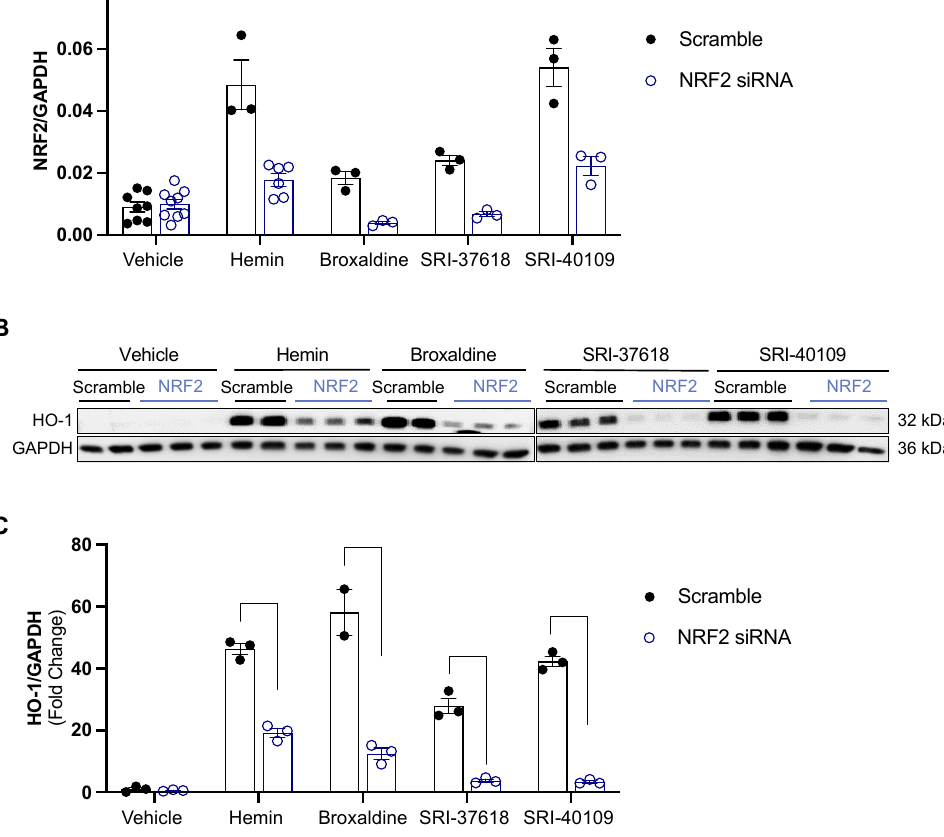
Figure 6. ( A ) Confirmation of NRF2 knockdown by real-time PCR. NRF2 gene expression is nor- malized to housekeeping gene GAPDH. ( B ) Western blot for HO-1 in cells exposed to compounds in the presence of NRF2-targeted siRNA or scramble siRNA control. ( C ) HO-1 protein expression normalized to corresponding GAPDH control expressed relative to scramble siRNA-treated vehicle control. Data analyzed by two-way ANOVA with Šídák’s multiple-comparison test.